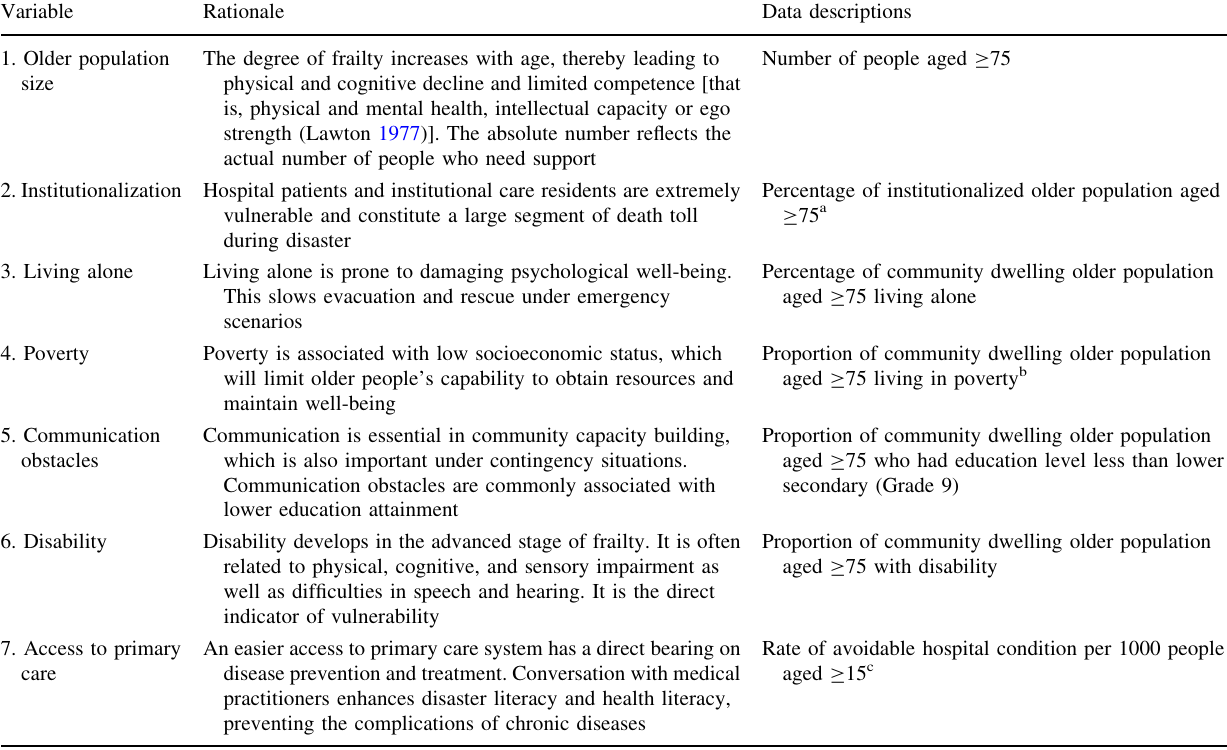
Table 1 Summary of variables for SVI for Hong Kong elders. Source Adapted from Gusmano et al. (2006) Variable